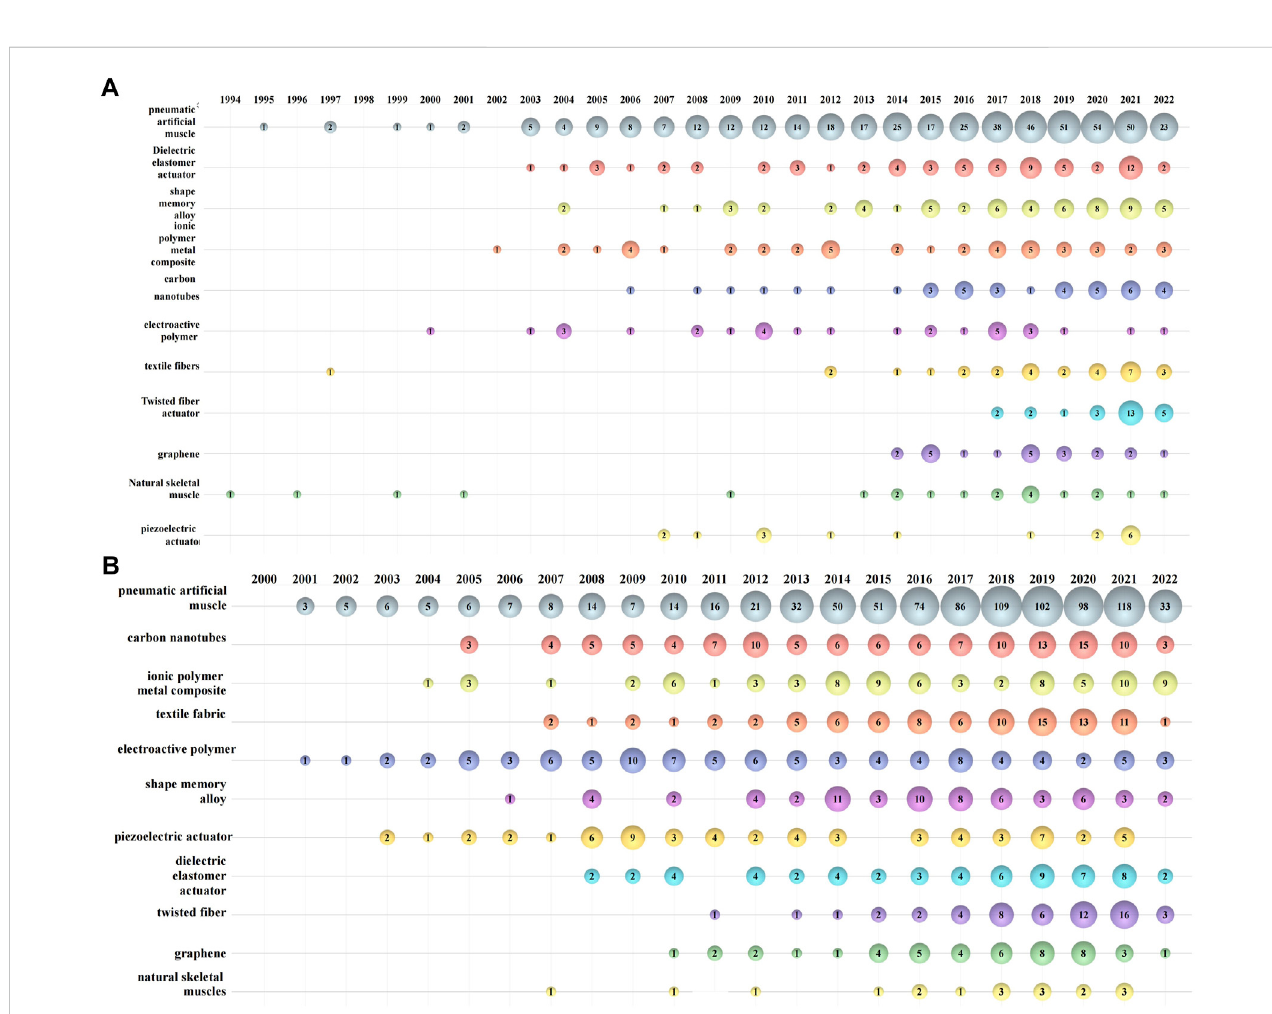
FIGURE 4 Bubble chart of various arti fi cial muscle development (A) development in papers (B) development in patents.